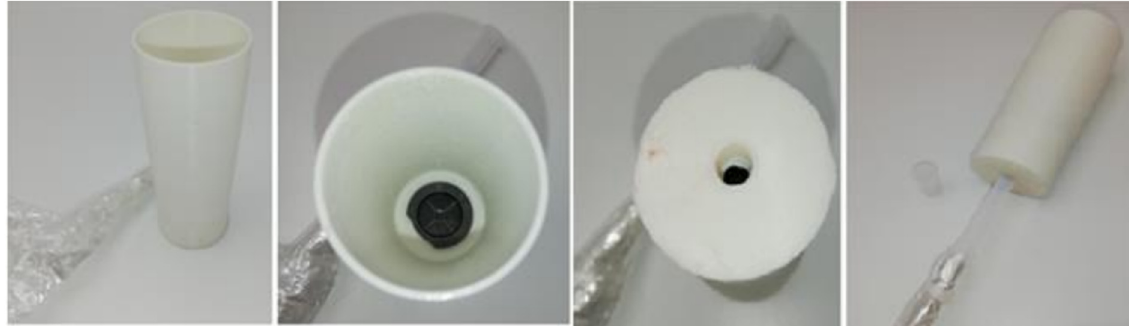
Figure 2. Nostril sampler connected to Nalophan bag.